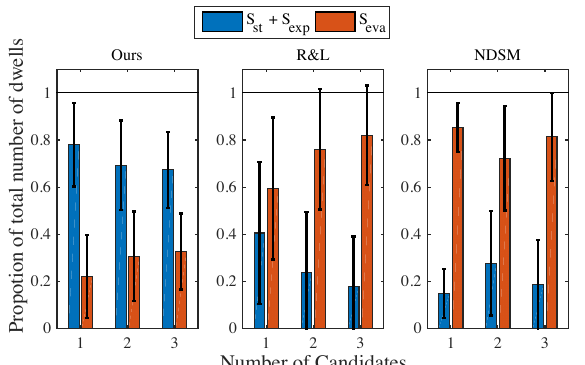
Figure 11 . The proportion of total dwells on selected items, non-selected candidates and other items when the number of candidates is 3. The whiskers represent standard